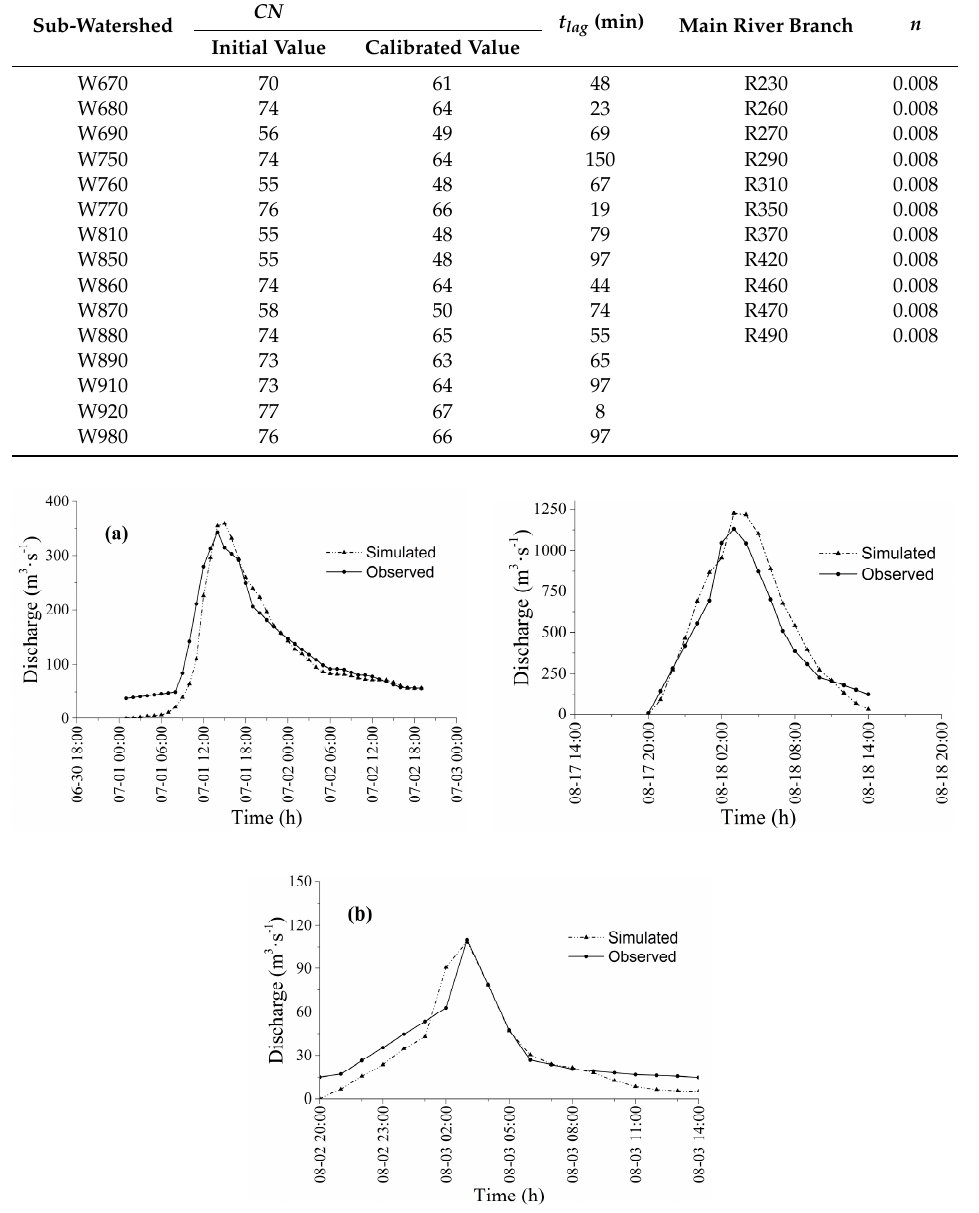
Figure 5. Simulated and observed hydrographs for calibration and validation: ( a ) calibration of the hydrograph for the floods on 01 July 2011 and 18 August 2012, ( b ) validation of the hydrograph for the flood on 02 August 2015.